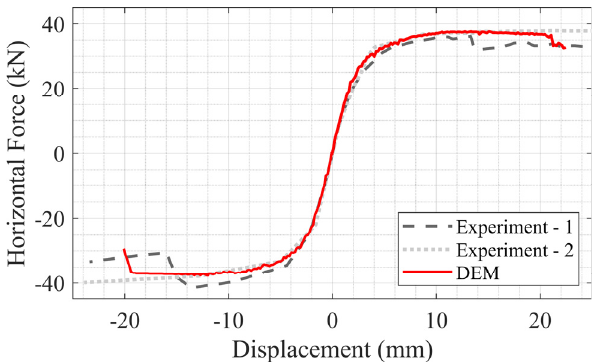
Figure 4. Comparison of experimental results (taken from [33]) against DEM.